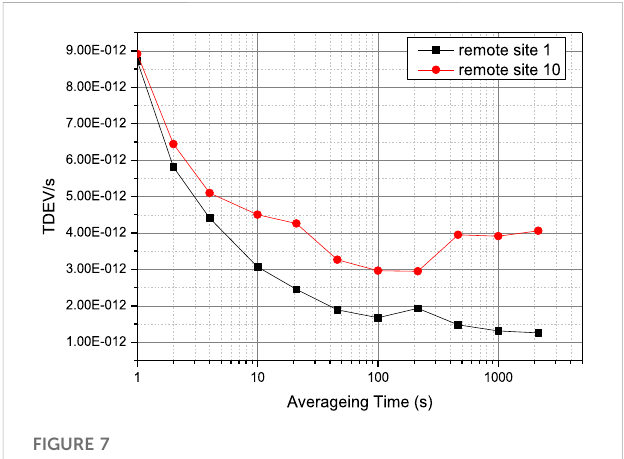
FIGURE 5 Comparison chart of TDEV before and after algorithm improvement.